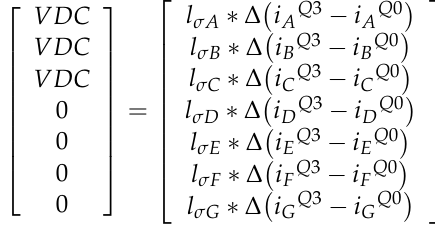
(23) Using the same assumption applied before and related to the drop voltage on the r s and the bac emf, Equation (24) can be obtained.